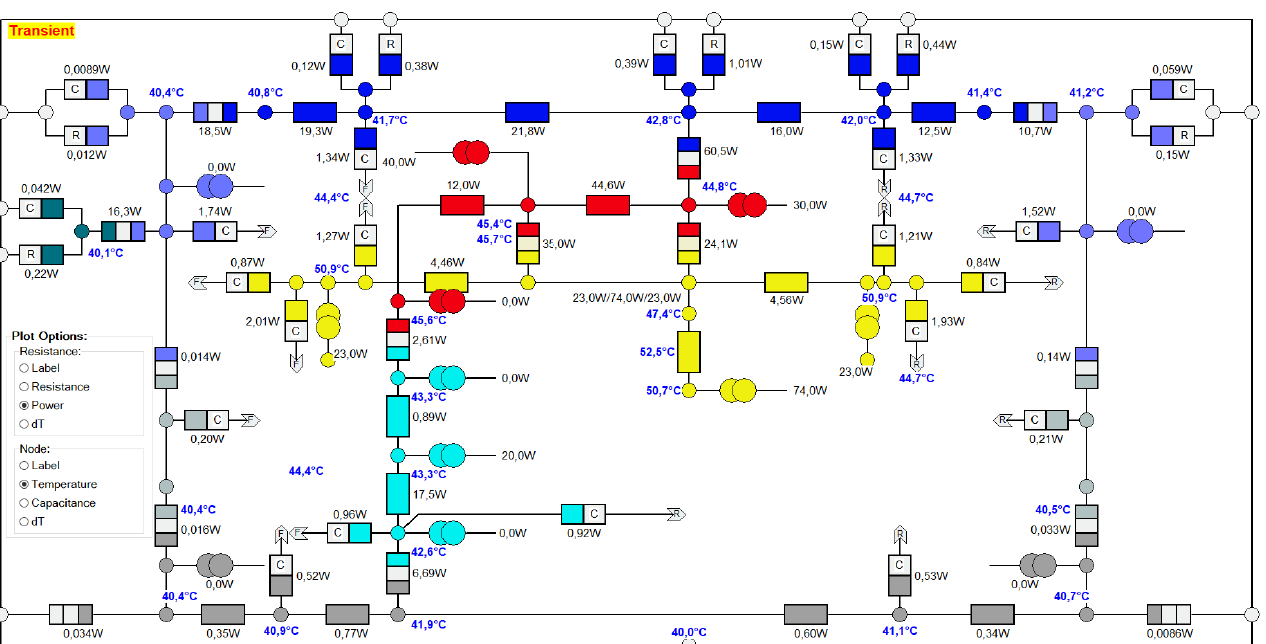
Figure 19. Schematic diagram of the adopted equivalent lumped-parameter thermal circuit of the SRM.